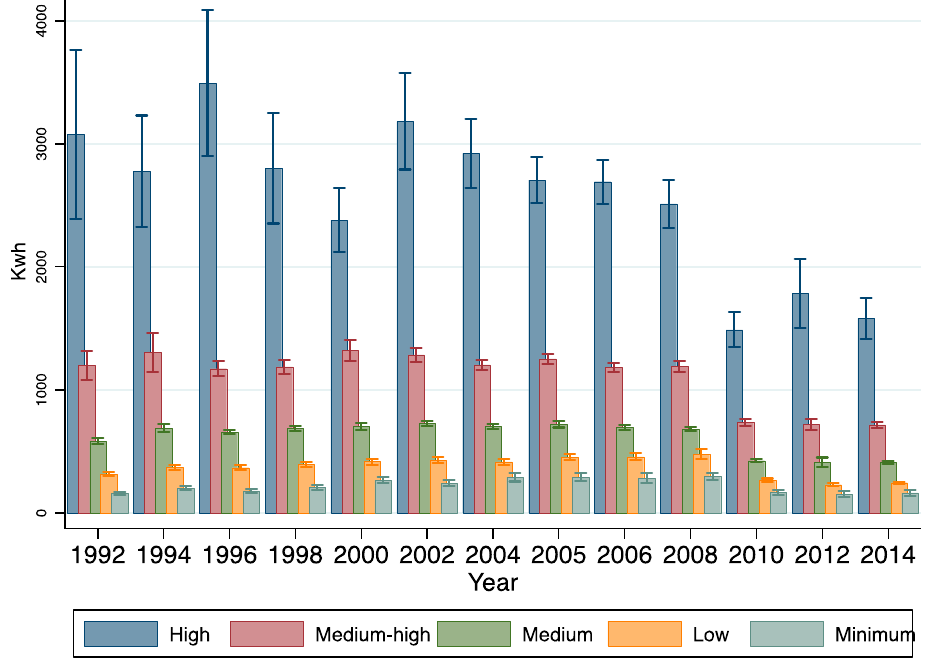
Figure 8. Electricity consumption per household by consumer practices’ latent classes. Mexico 1992–2014. Kilowatt hours (Kwh) and confidence intervals (95%). Source: Authors’ calculations, ENIGH (1992–2014).